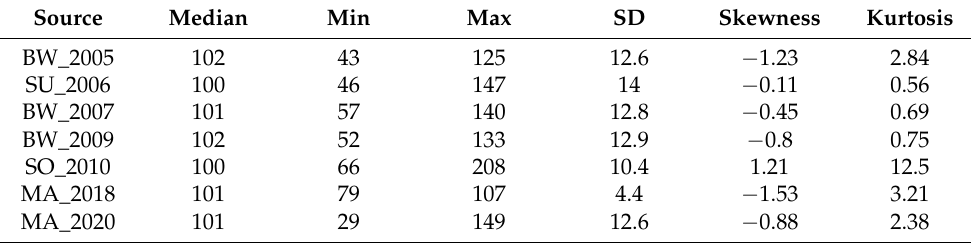
Table 4. Descriptive statistics of standardized crop yields over seven years (means = 100).